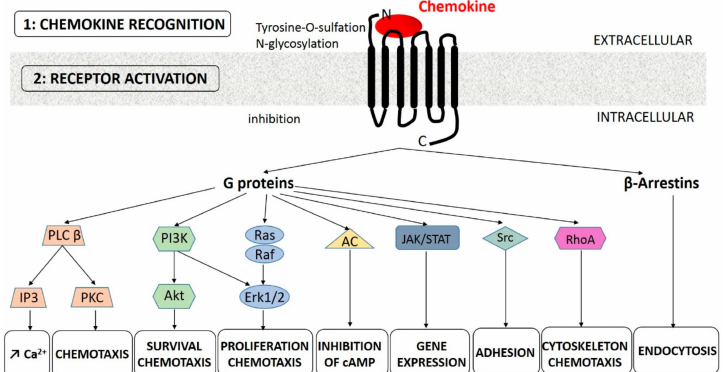
Figure 1. Chemokine-receptor interaction and the activation of downstream signaling pathways. Two main interactions between chemokines and their receptors are generally accepted: The N-terminal region of the chemokine binds in the pocket of the receptor transmembrane helical domain, while the N-terminal region of the receptor binds to a structural loop of the chemokine [37]. Evidence for